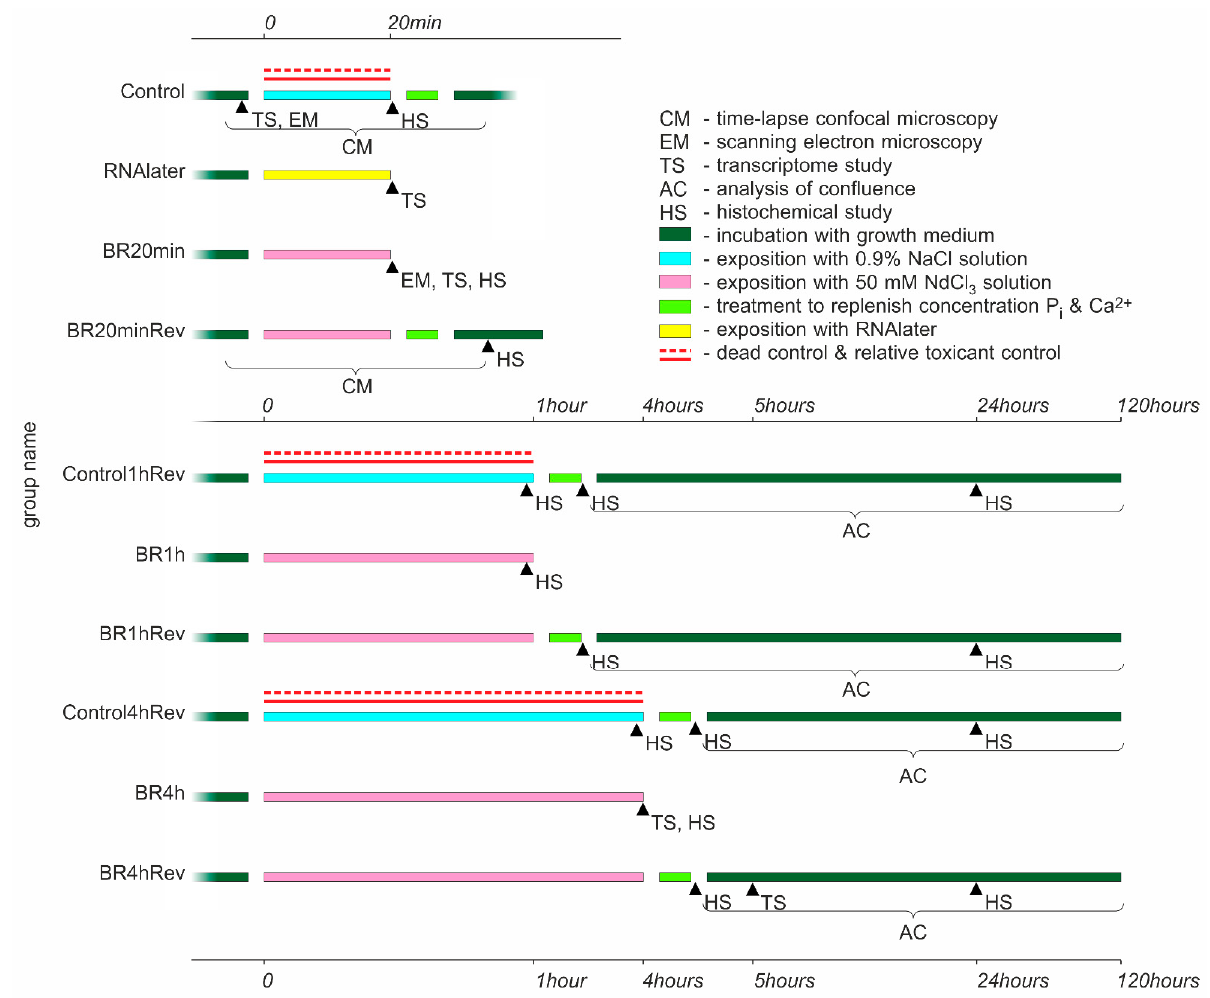
Figure 1. Sampling and type of analysis conducted on the cell culture after incubation with isotonic lanthanoid-containing solution and control substances.